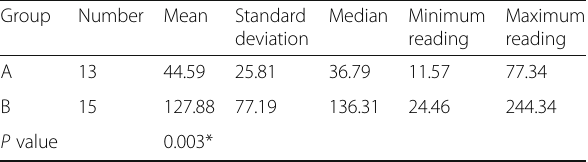
Table 4 Readings for thickness of repair cementum